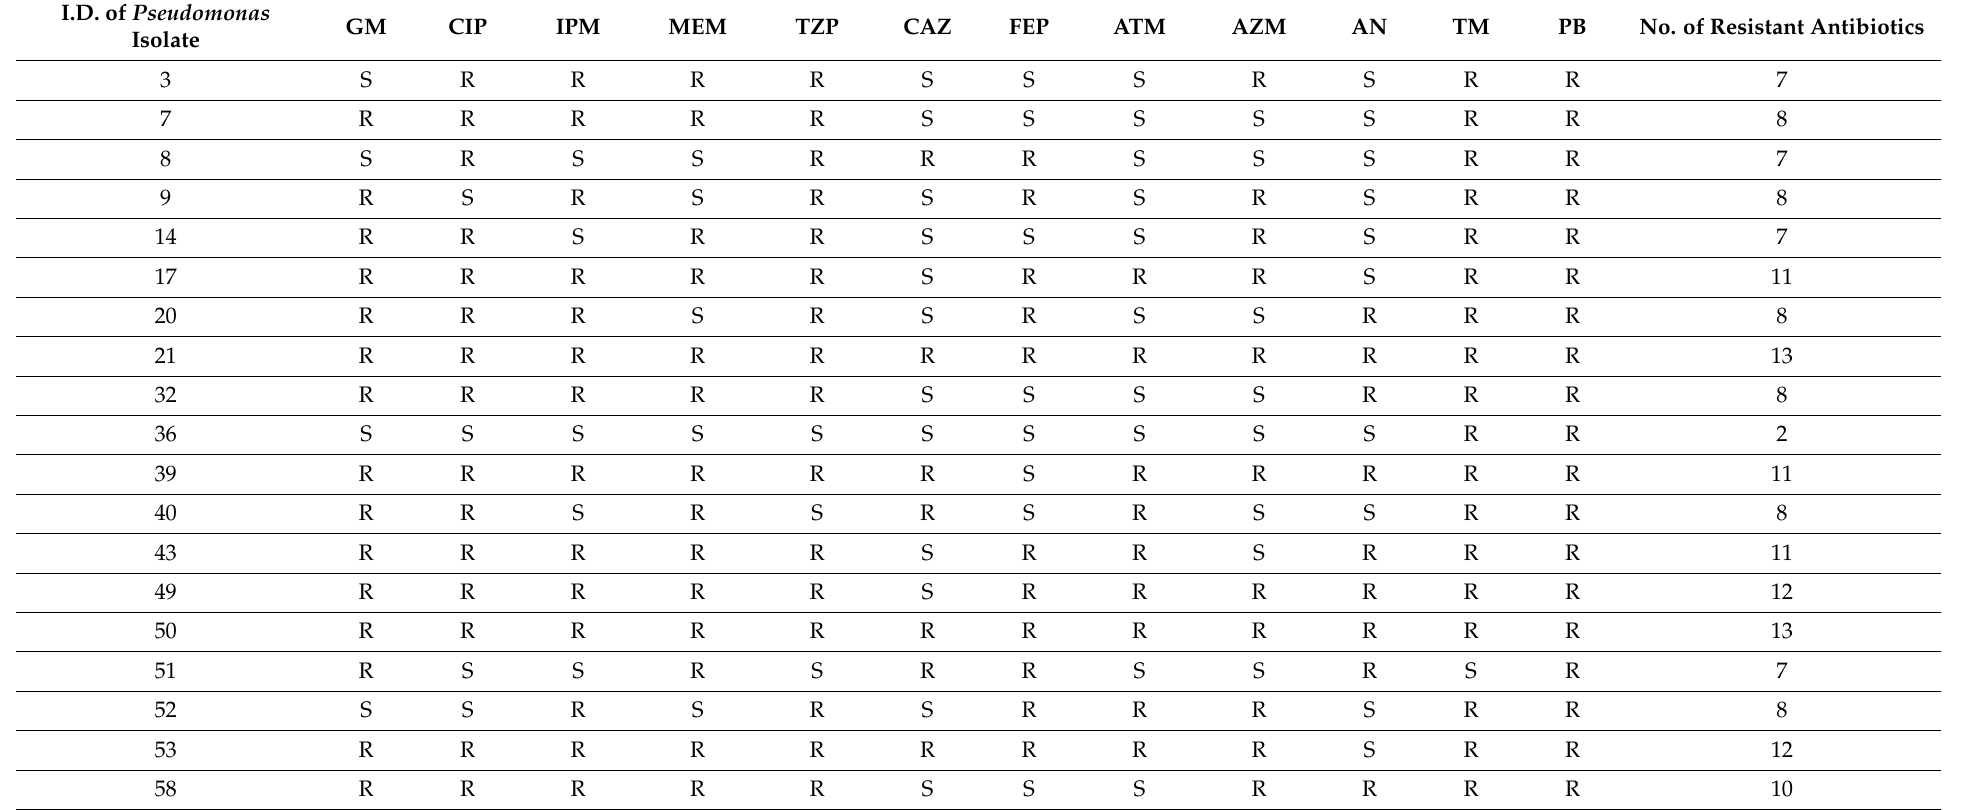
Table 4. Results of antibiotic susceptibility testing of Pseudomonas aeruginosa isolates from the skin ( n =